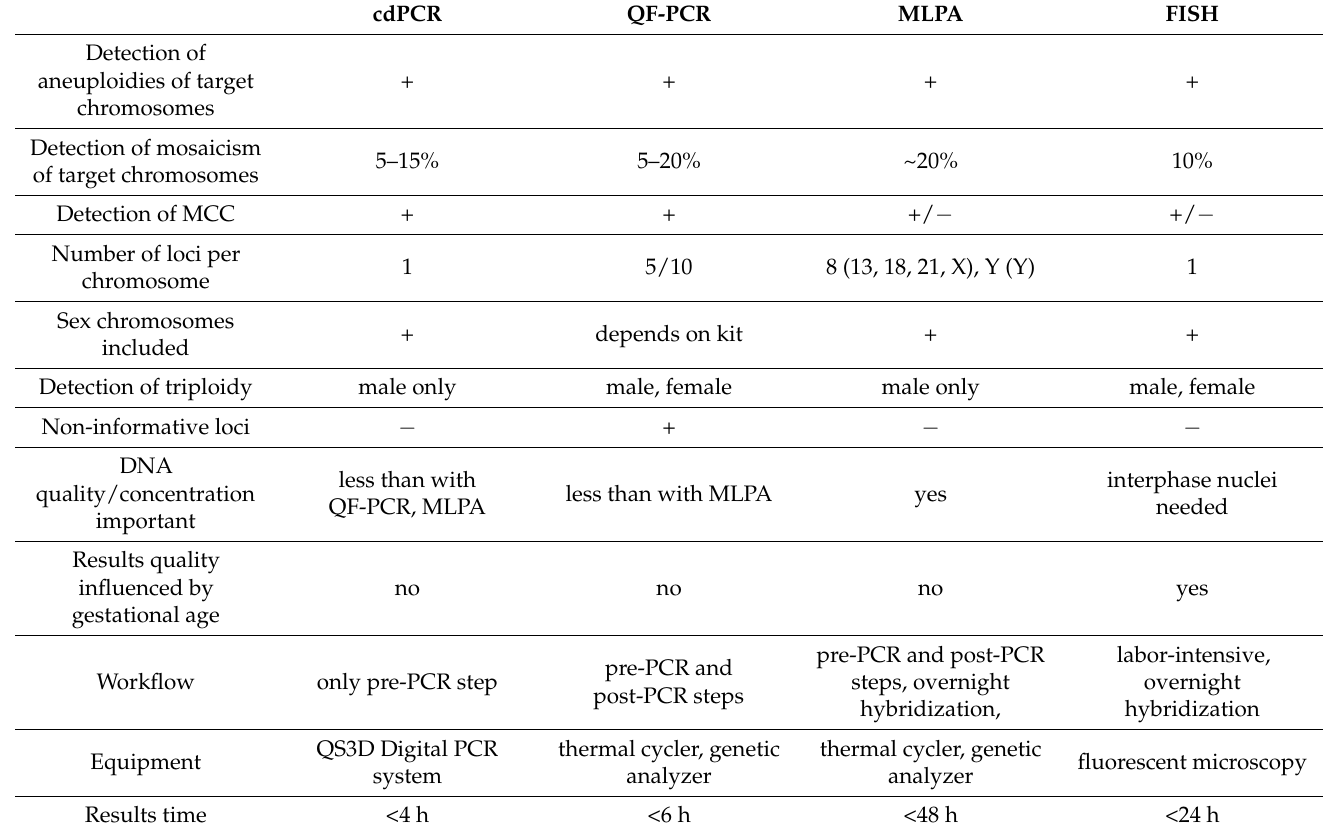
Table 2. Comparison of digital PCR and routinely used molecular methods for aneuploidy testing. Modified, based on previously provided data